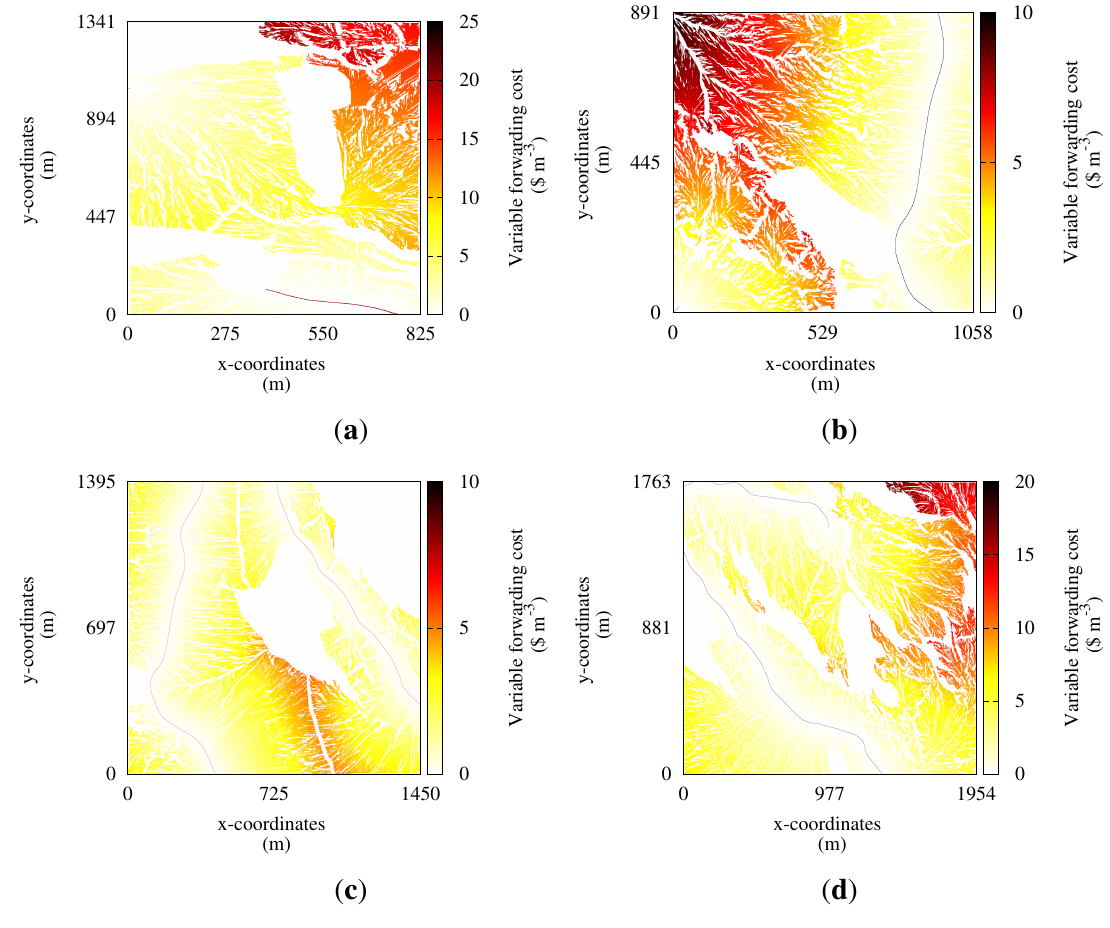
Figure 2. Heat maps of the variable forwarding cost. Roads can be seen as dotted, dark red curves. ( a ) Case 1. Note the short forest road ending close to x = 0 , y = 1000 ; ( b ) Case 2; ( c ) Case 3; ( d ) Case 4.